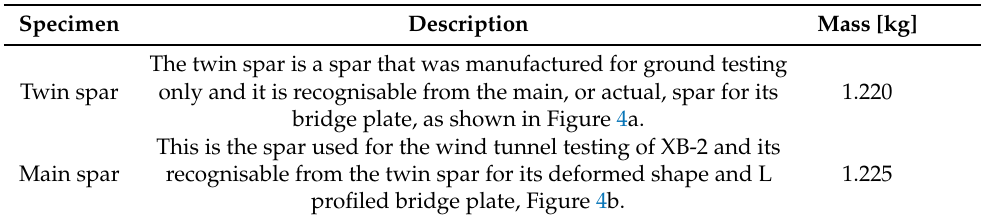
Table 3. Specimens of the testing